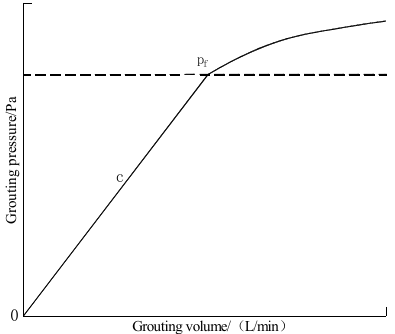
Figure 2. Relationship between grouting pressure and amount.